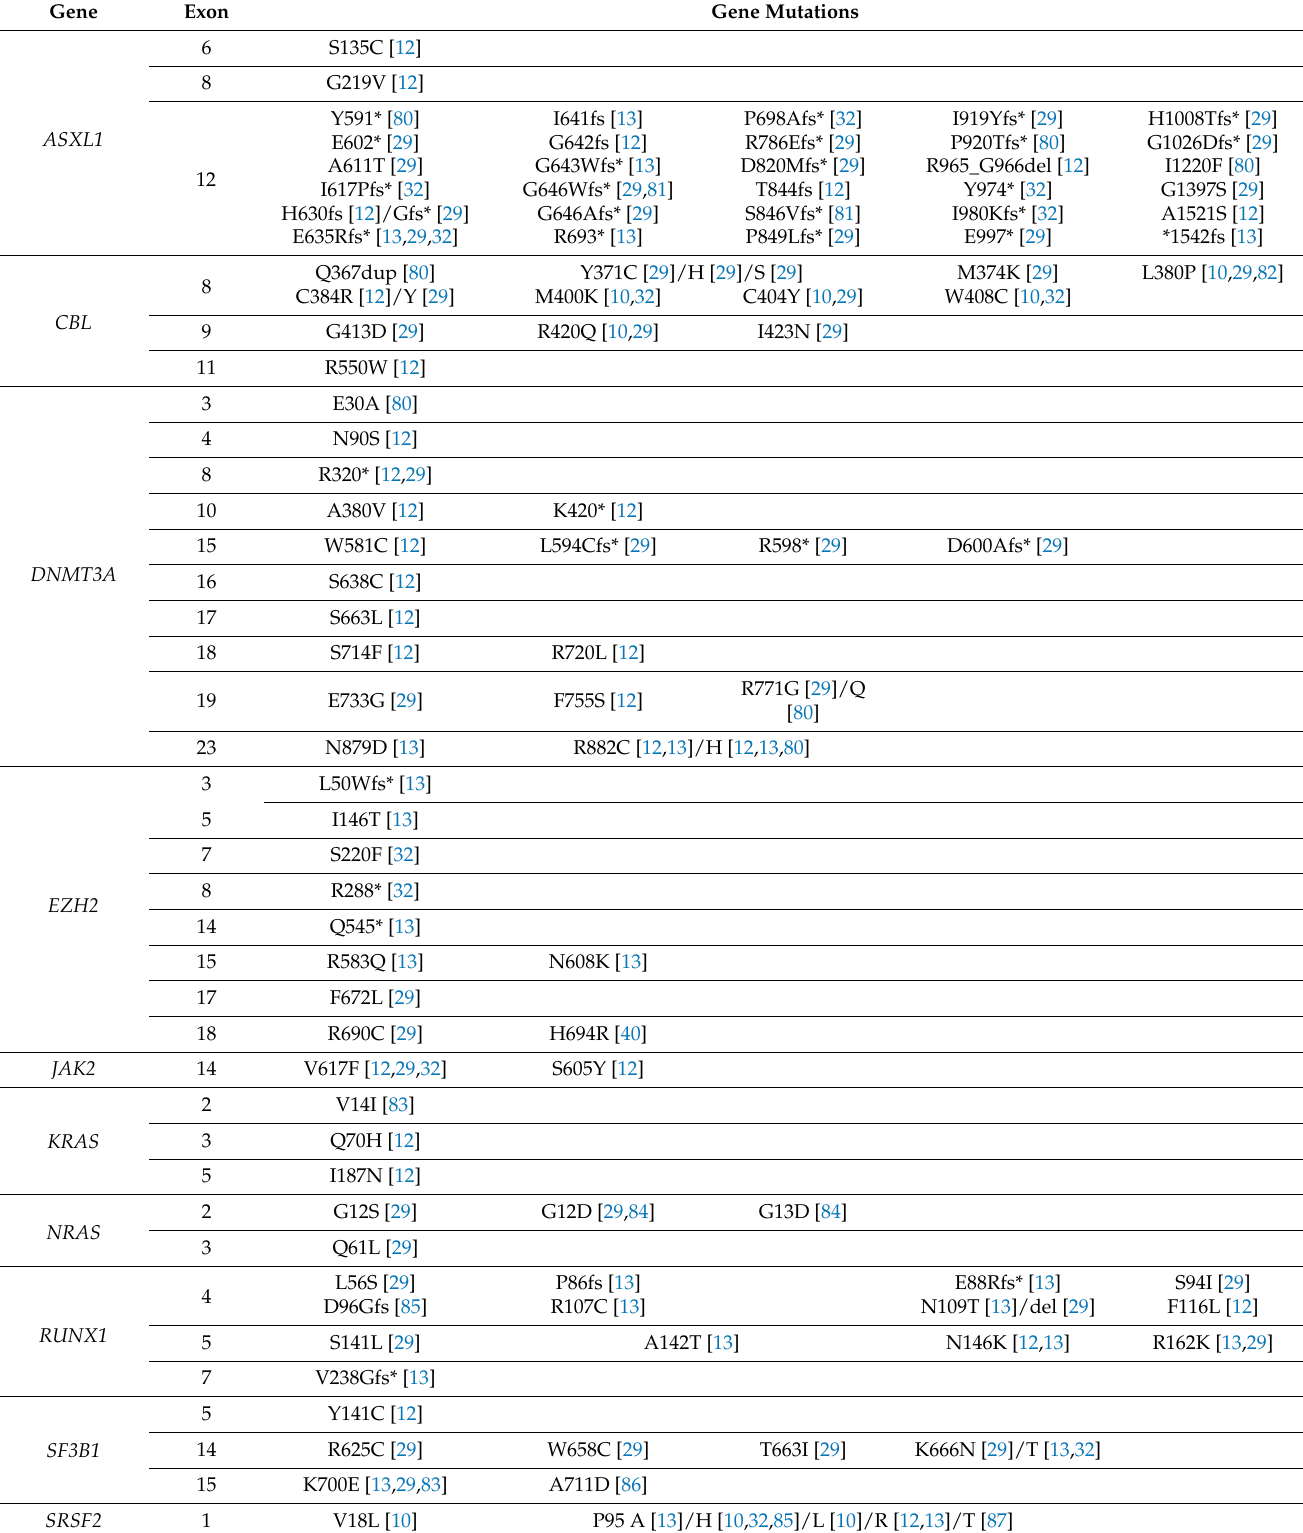
Table 2. Mutations in genes other than KIT reported in systemic